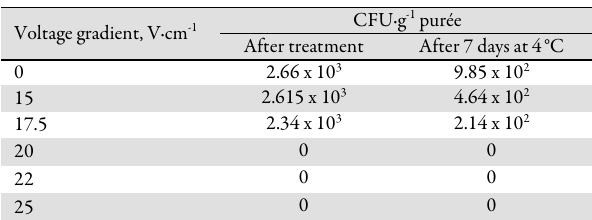
Table 3. Number of yeasts and molds per gram sample pear purée Voltage gradient, V·cm -1